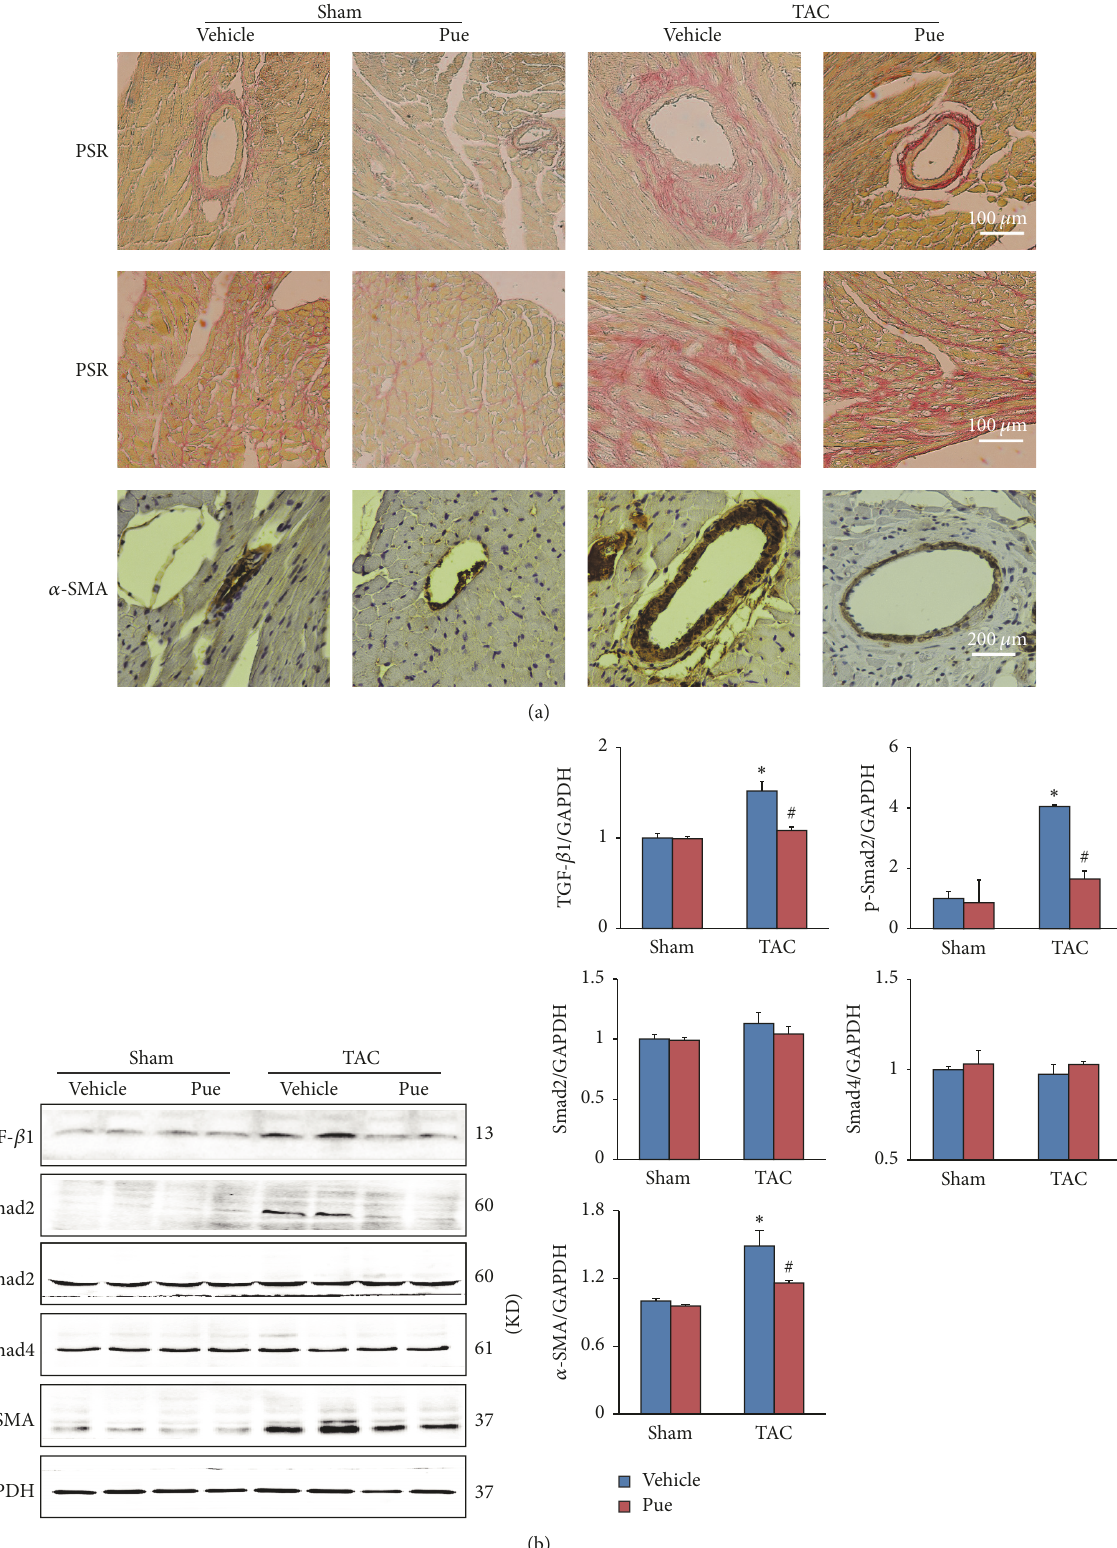
Figure 1: Pressure overload-induced cardiac fibrosis was alleviated in puerarin-treated mice . (a) Histological sections of the left ventricle in indicated groups were stained with PSR for fibrosis (upper and middle panel, scale bars: 100 𝜇 m). 𝛼 -SMA was detected with immunohistochemistry (lower panel, scale bars: 200 𝜇 m). (b) TGF- 𝛽 1/Smad2 signaling pathway and 𝛼 -SMA protein in indicated groups were determined by WB, normalized to GAPDH (𝑛 = 6) . ∗ 𝑝 < 0.05 versus sham + vehicle group; # 𝑝 < 0.05 versus TAC + vehicle